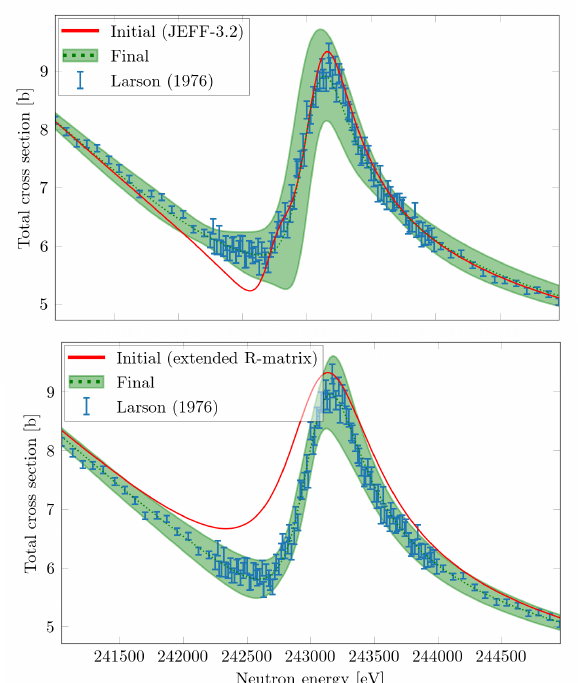
Figure 10. Uncertainty band obtained with the local criteria with the JEFF-3.2 prior (top) and with the extended model (bottom).